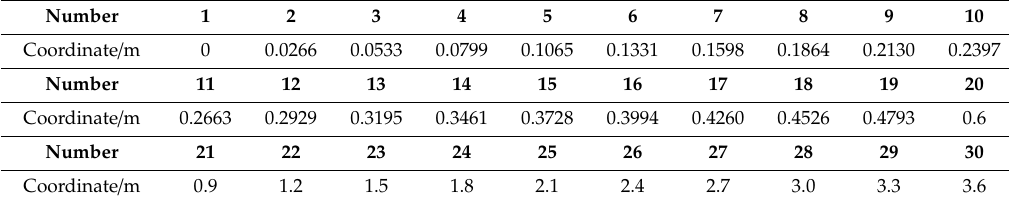
Table 3. Y-values of the selected calculation points of the pavement